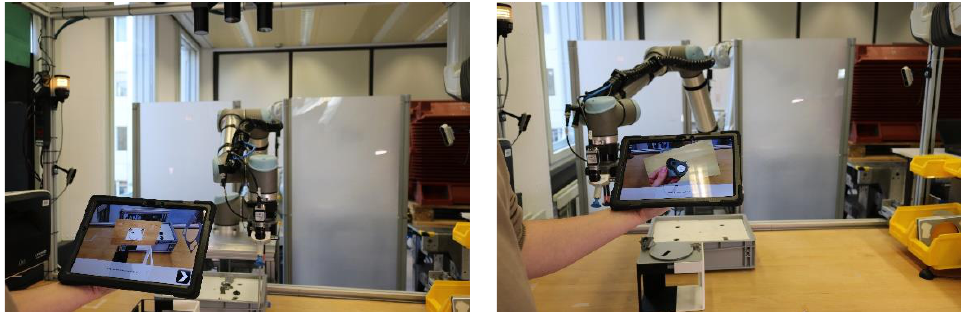
Figure 9. Real implementation of the work cell in a laboratory environment.